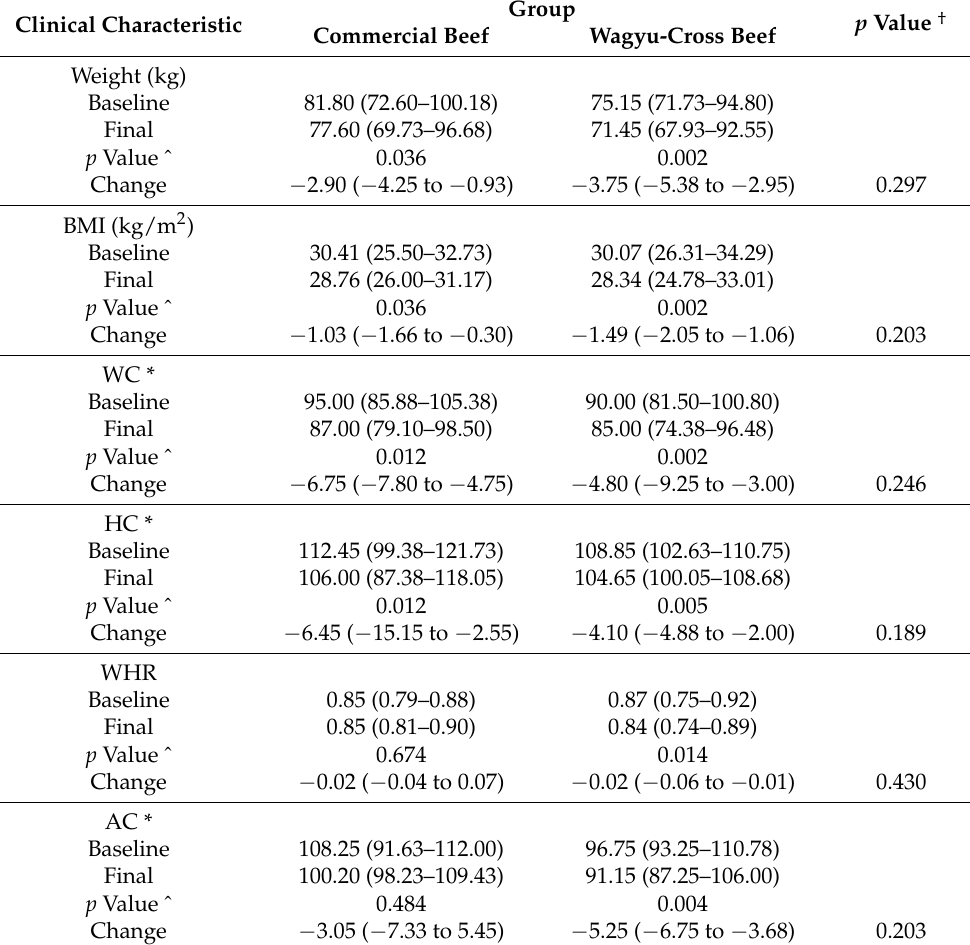
Table 3. Comparison of anthropometric measurements before and after food intervention 1 .